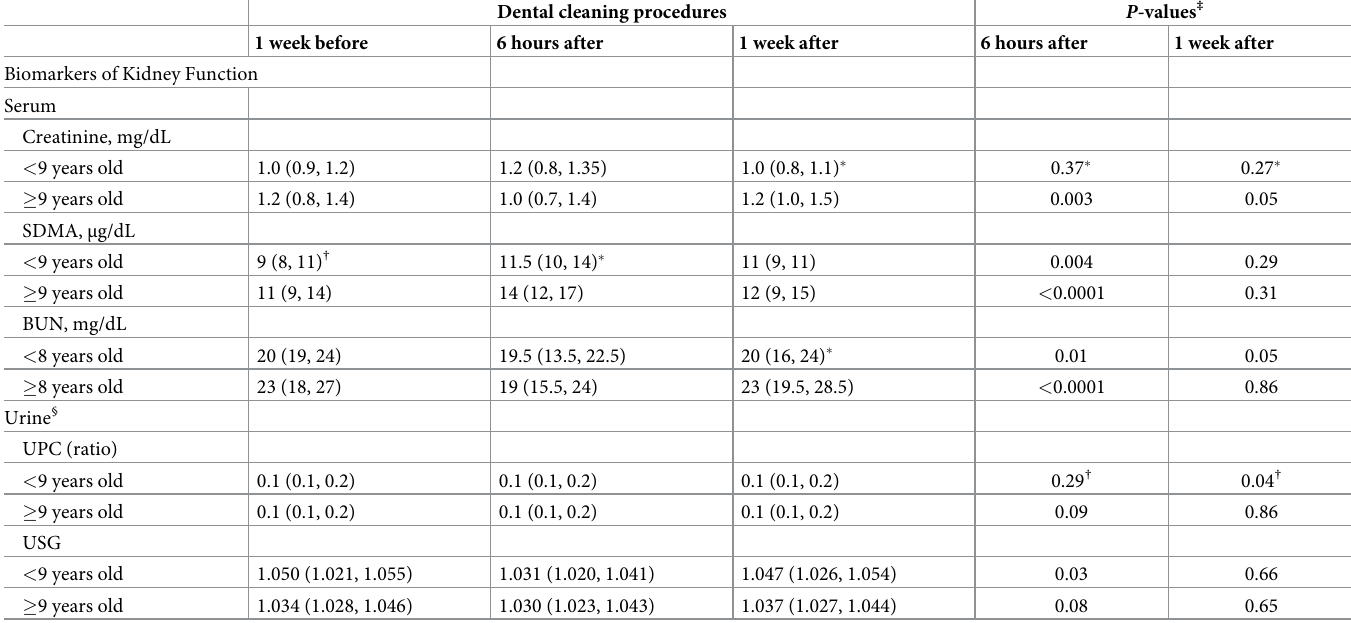
Table 3. Serum and urine kidney function biomarkers before and after general anesthesia and dental cleaning procedures in cats and dogs with periodontal disease stratified by age (n = 62) � . Dental cleaning